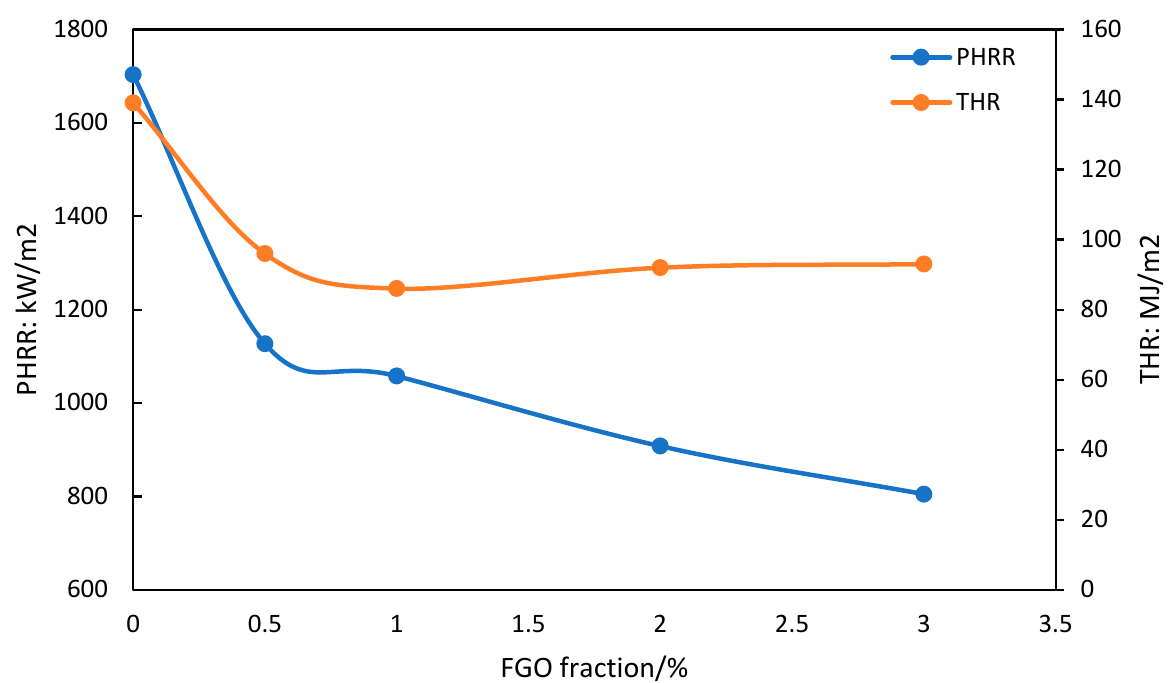
Figure 4. Fire-safety results obtained from cone calorimetry (heat flux of 35 kW/m 2 in nitrogen), showing the effect of FGO weight fraction on the peak heat-release rate (PHHR) and total heat release (THR) for FGO/PS nanocomposites [86].